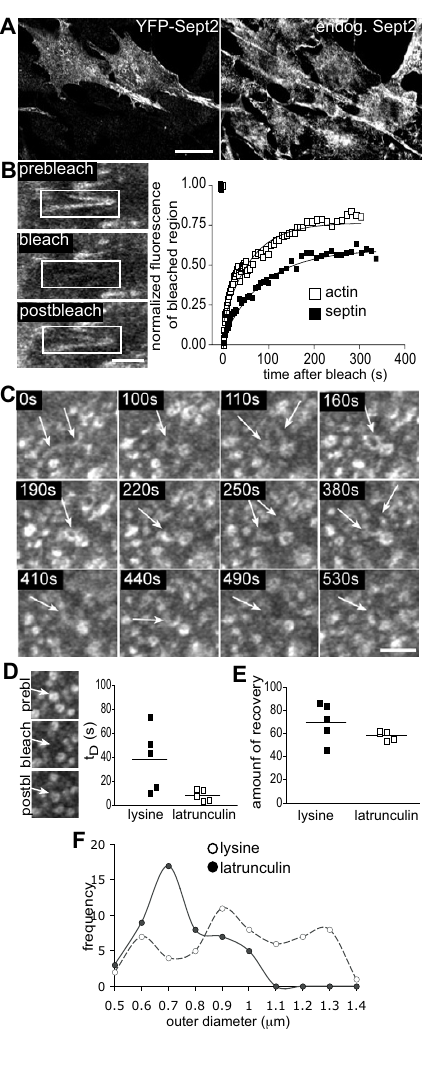
Figure 6 Septin2 forms highly dynamic filaments and rings. (A) YFP-Septin2 has the same distribution like endogenous Septin2 and it does not alter the organisation of endogenous Septin2. Bar, 20 µ m (B) Photobleach experiment. NRK cells were trans- fected with either YFP-Septin2 or GFP-actin. Part of the filaments was bleached and recovery monitored over time. The ratio between mean fluorescence intensity of the prebleached box and the mean fluorescence of the whole cell was normalised to the prebleach ratio and expressed as a function of time (Materials and Methods). The graph shows representative recovery curves, which were fitted to a single exponential curve (solid lines) to calculate t s and amount of recovery. n = 5. Images show a single confocal section of YFP-Septin2 filaments in NRK cells. Bar, 4 µ m. (C) Images of a time-laps movie of YFP-Septin2 in the cell body of ruffling NRK-cells. Arrows indicate the formation cycle of a ring. Bar, 2 µ m. (D,E) Photobleach experiments of YFP-Septin2 rings (also see additional file 1 for lysine/ruffling cells and additional file 2 for latrunculin). NRK cells growing on lysine-coated coverslips to induce ruffles were transfected with YFP-Septin2. Rings formed in the cell body were bleached and recovery monitored over time. For bleaching of Septin2 rings upon latrunculin treatment, normal NRK cells were transfected with YFP-Septin2 and treated with Latrunculin B for 20–25 Min before photobleaching. The data were analysed as in B to cal- culate t s of recovery (D) and amount of recovery (E). n = 5. Images show a single confocal section of YFP-Septin2 rings in ruf- fling NRK cells. (F) Quantitative comparison of outer diameters of Septin2 rings in ruffling cells (lysine, empty circles) and upon latrunculin treatment (filled circles). Measurements were done on images of cells transfected with